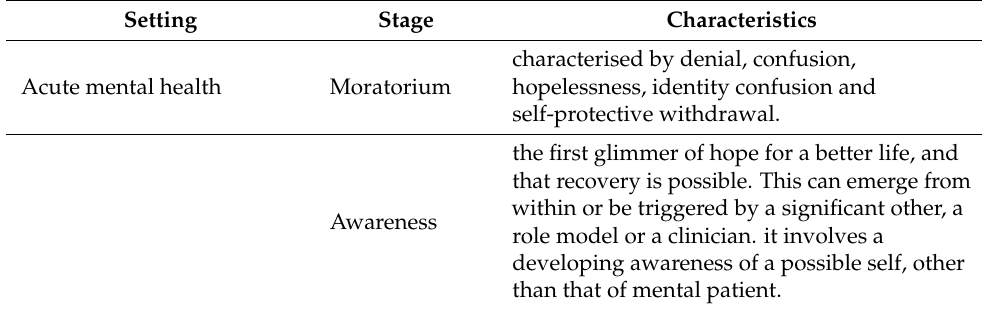
Table 4. Phases of recovery identified from recovery narratives